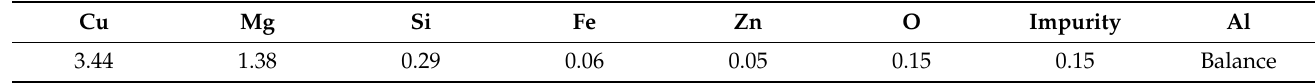
Table 1. Chemical compositions of 15%SiCp/2009 aluminum matrix composite